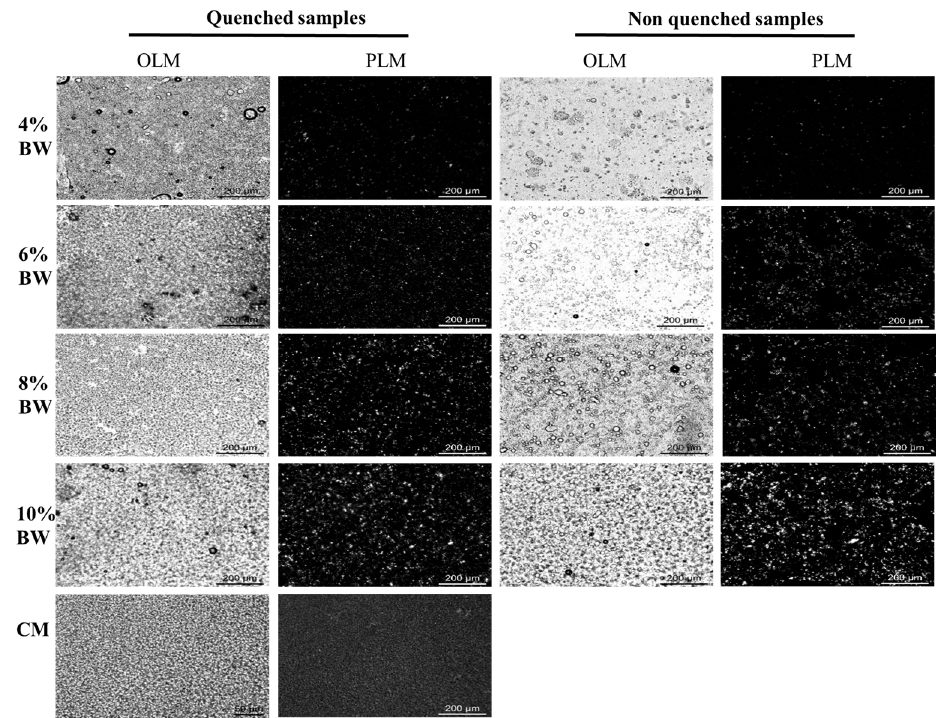
Figure 3. Bright-field and polarized light images of BW oleogel-based margarine and commercial margarine, respectively.